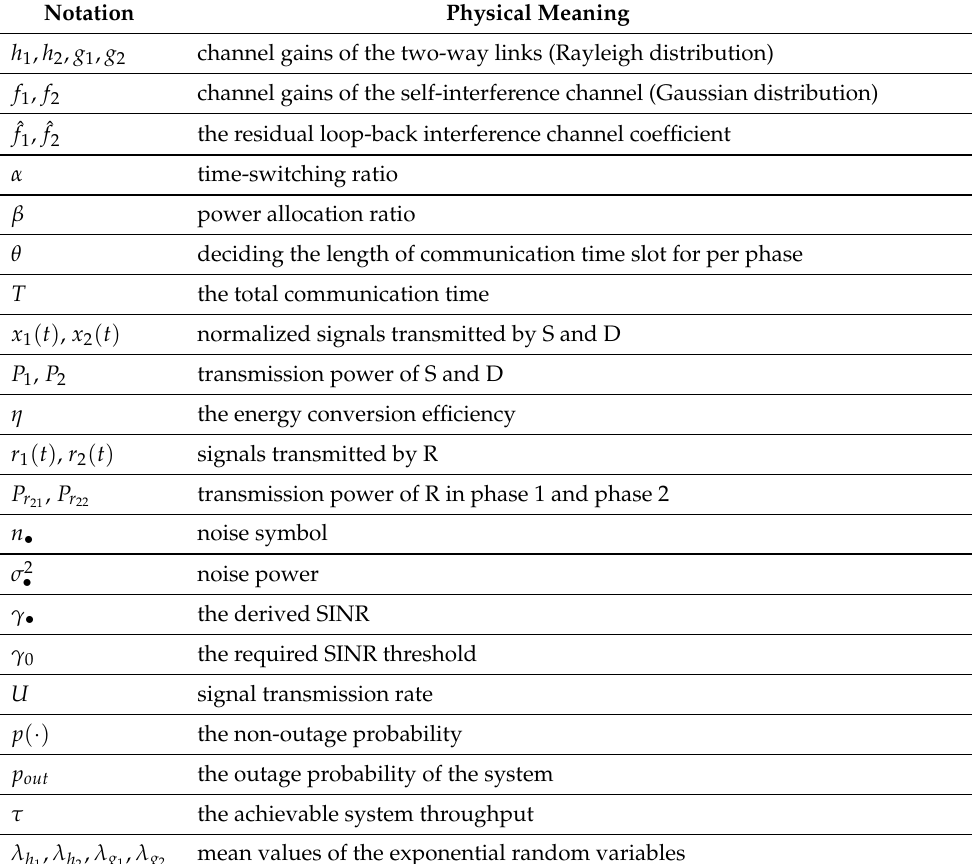
Figure 1. Full-duplex two-way relay system. Table 1. Notation